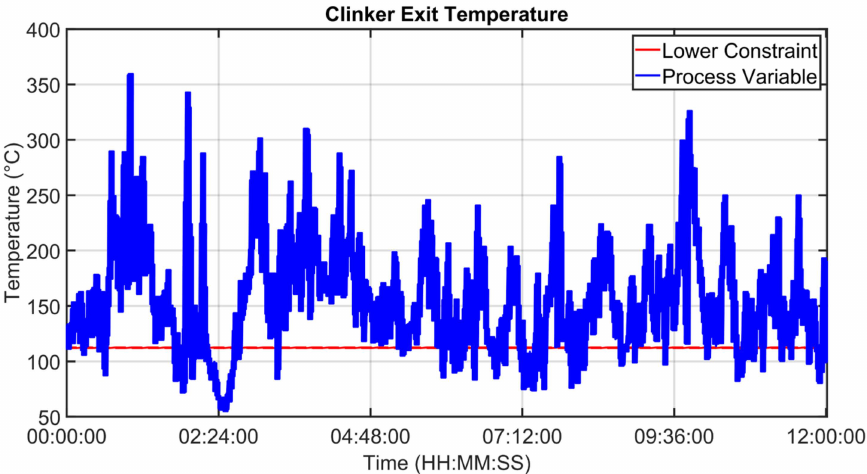
Figure 30. Grate cooler APC system: field results (clinker exit temperature